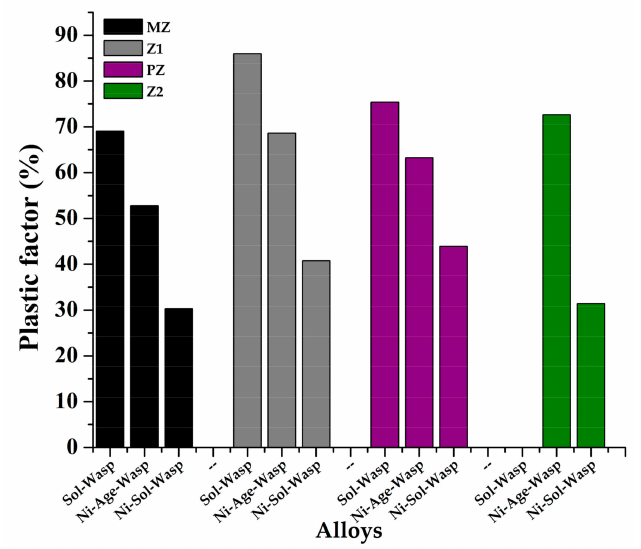
Figure 18. Bars graph of plasticity factor in the di ff erent tested zones of the Sol-Wasp, Ni-Age-Wasp, and Ni-Sol-Wasp